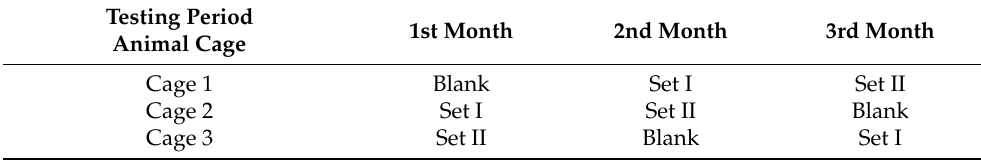
Figure 3. Pictures of; ( a ) specimens for anti-rodent testing; ( b ) testing environment. Table 2. Experimental design of gnawing test.